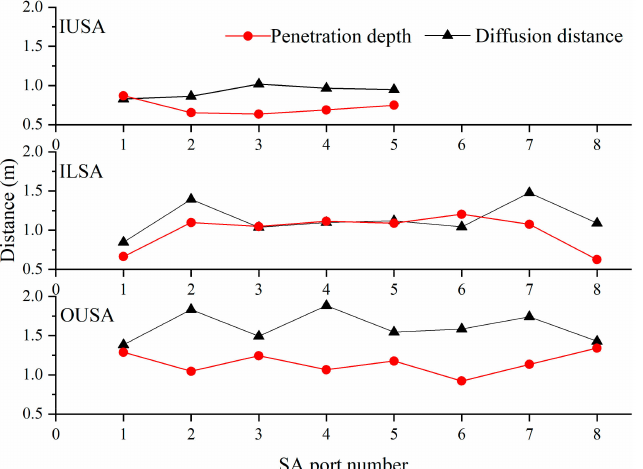
Figure 14. Simulation results of SA penetration depth and lateral diffusion distance under 60% BMCR